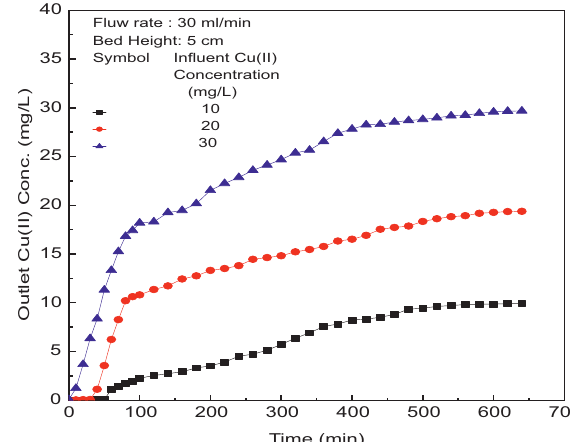
Figure 5. Effect of influent metal ions concentration for the removal of Cu(II) on coconut shell at constant bed height and flow rate